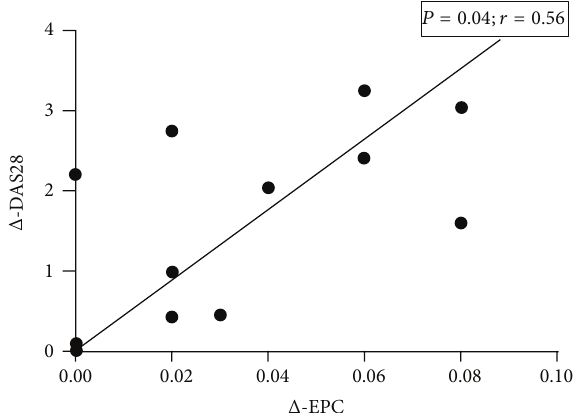
Figure 3: Correlation between mean increase of EPCs and mean decrease of DAS28 after 3 months of anti-TNF treatment. EPCs:endothelial progenitor cells and DAS28: disease activity score